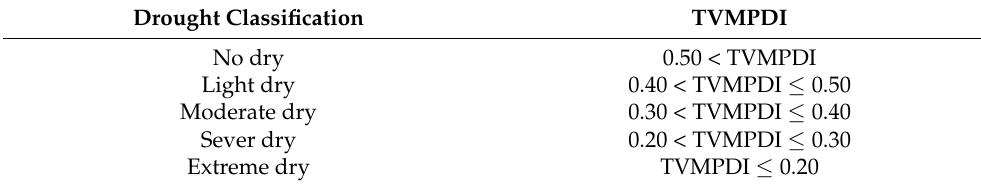
Table 3. Drought classification. Drought